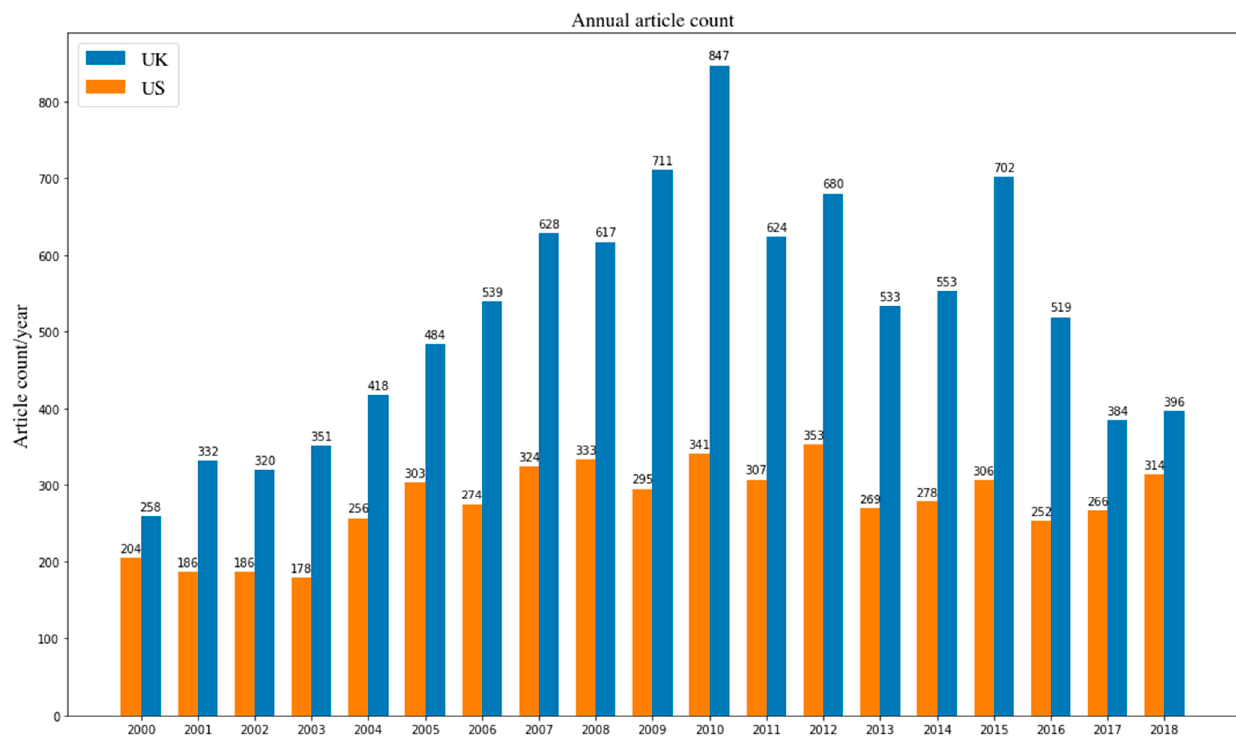
Figure 1. Articles per year mentioning atheists by country.